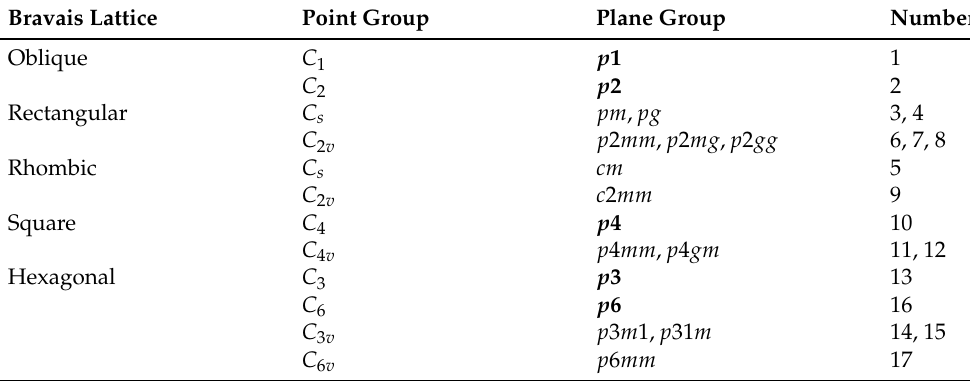
Table 5. Plane lattices and space groups. The 5 groups without mirror operations, that are hosts for chiral objects, are marked in bold. The numbering of the groups is according to Ref.